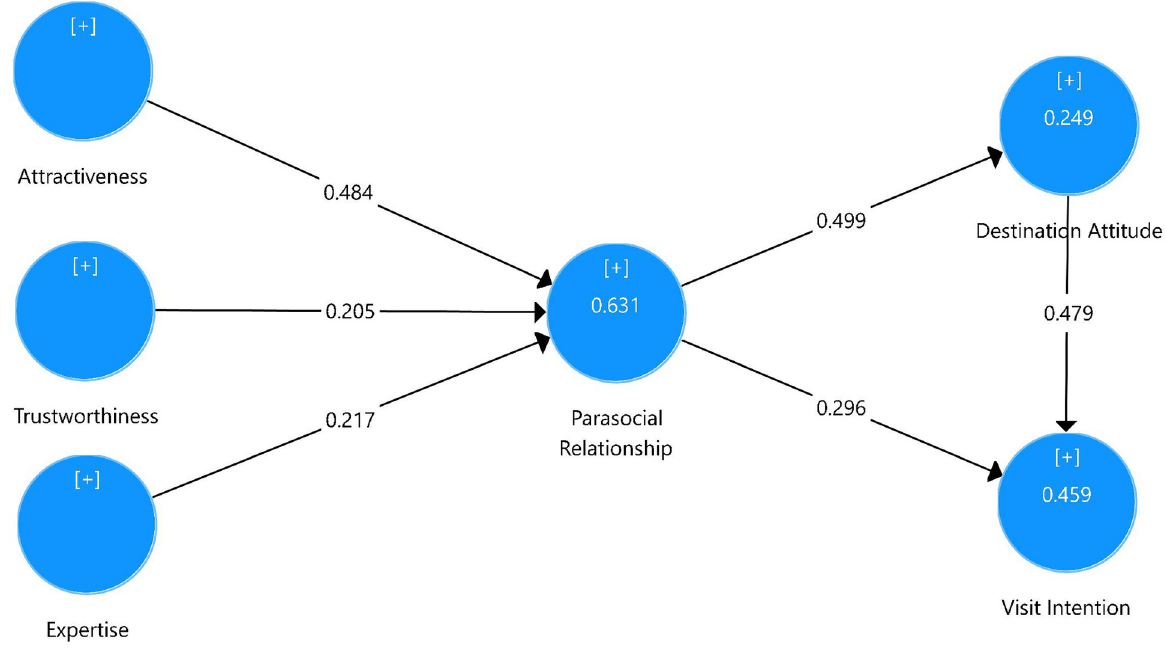
Fig 2. Path Coefficients in the structural model.